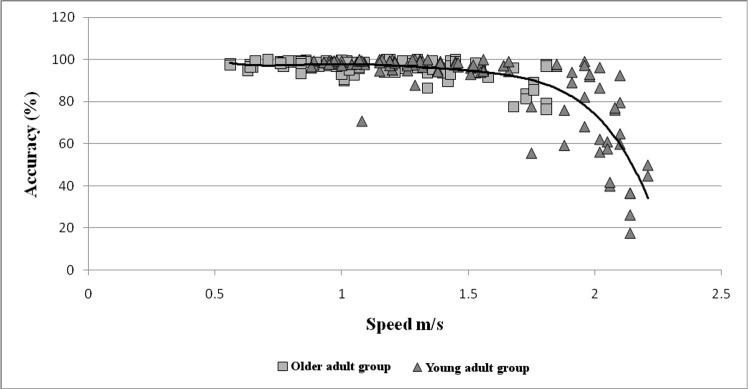
Regression model: Association of speed on reliability of ADAMO Care Watch of the whole sample.